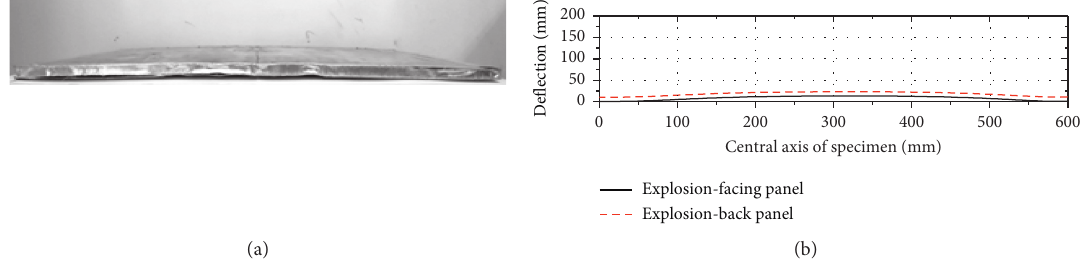
Figure 15: Side deformation and deflection of ST2. (a) Side view of ST2 deformation. (b) ST2 deflection data curve.